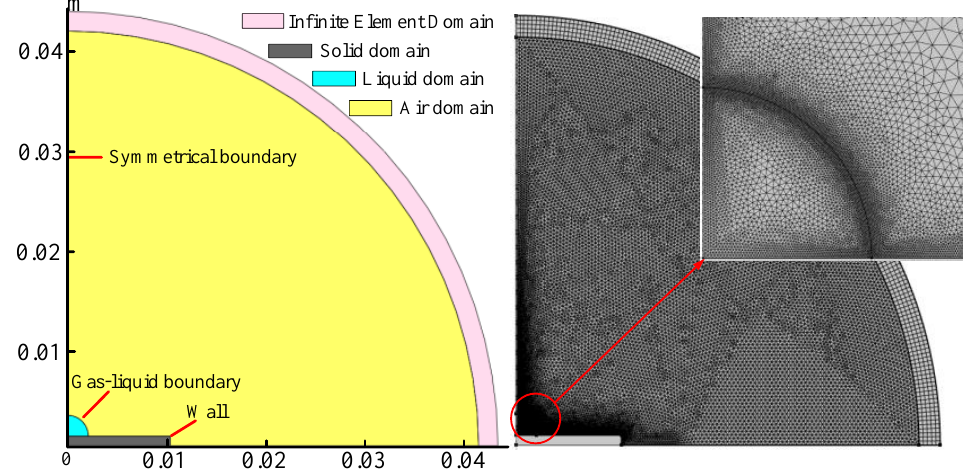
Figure 1. Model boundary conditions and mesh distribution.